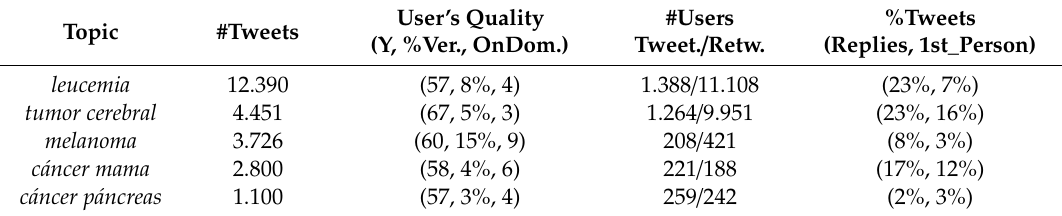
Table 6. Top frequent topics (Spanish